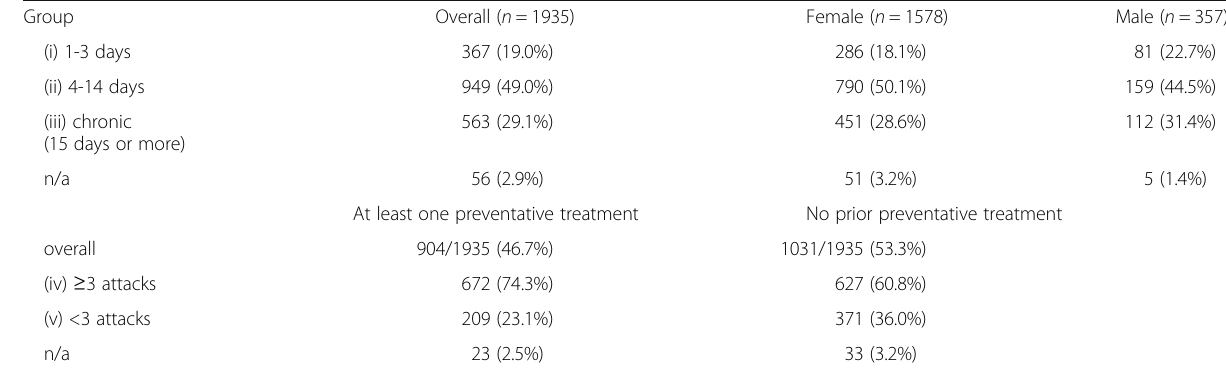
Table 1 All migraine patients grouped by sex, amount of migraine days, number of attacks and previous preventative treatments in their lifetime, overall ( n = 1,935). n/a: not applicable